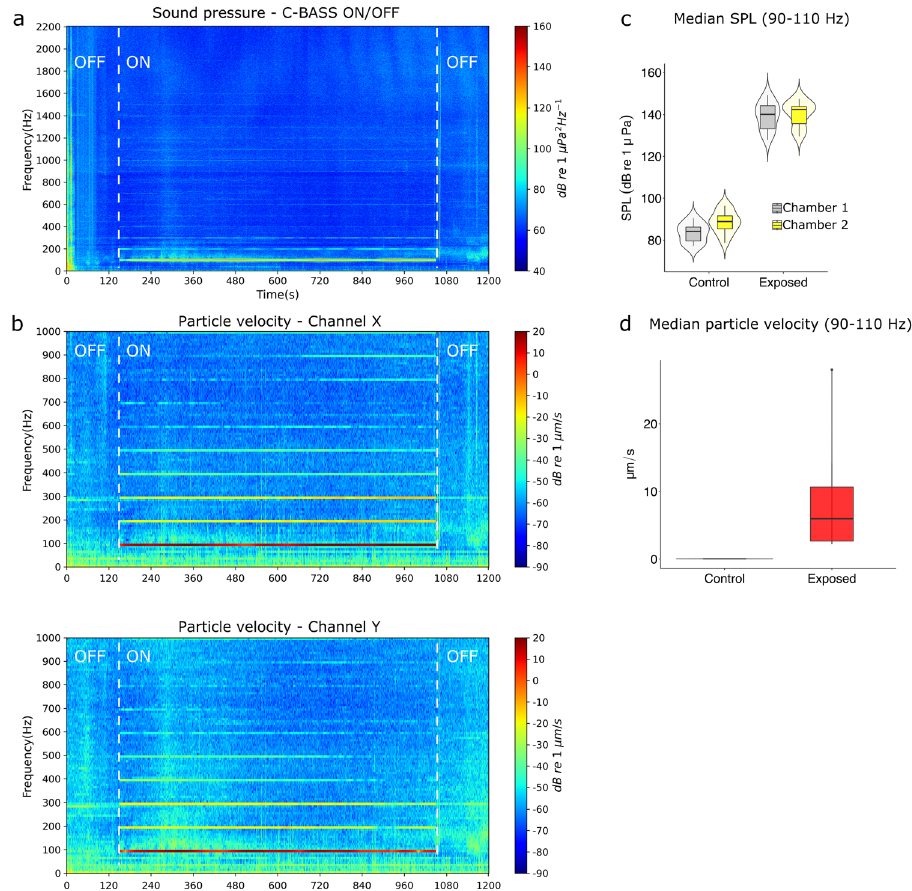
Fig. 4 Spectrograms of the acoustic pressure (received at chamber 2) and particle velocity across frequencies during a 15 min-long sound transmission at 100 Hz (transmission NO.4-15). The particle velocity was measured by the M20-110 acoustic vector sensor and the acoustic pressure was measured by the AMX-Remora hydrophone mounted on the chamber. Both sensors were drifting at 5 m depth in the fjord during the experiment. a Spectrogram of power spectrum density during a time period with the sound projector switched OFF, then switched ON (dashed white line) and then OFF again (dashed white line). The processing parameters are segment time length of 10 s, 80% overlap, fast Fourier transform length of 4410, and Hann window. b Horizontal particle velocity ( dB re 1 μ m/s) during one of the tests, with the sound projector switched OFF and then switched ON. The particle velocity is displayed both from the X channel and the Y channel of the M20-110 sensor. The velocity is calculated every second with no overlap. c Median sound pressure level (SPL) at 100 Hz received by the chambers when the sound projector was switched OFF (Control) ( N = 11 for chamber 1, N = 11 for chamber 2) and when the sound projector was switched ON (Exposed) ( N = 11 for chamber 1, N = 12 for chamber 2). d Median particle velocity measured by the M20-110 when the sound projector was switched OFF (Control; N = 11) and when the sound projector was switched ON (Exposed; N =